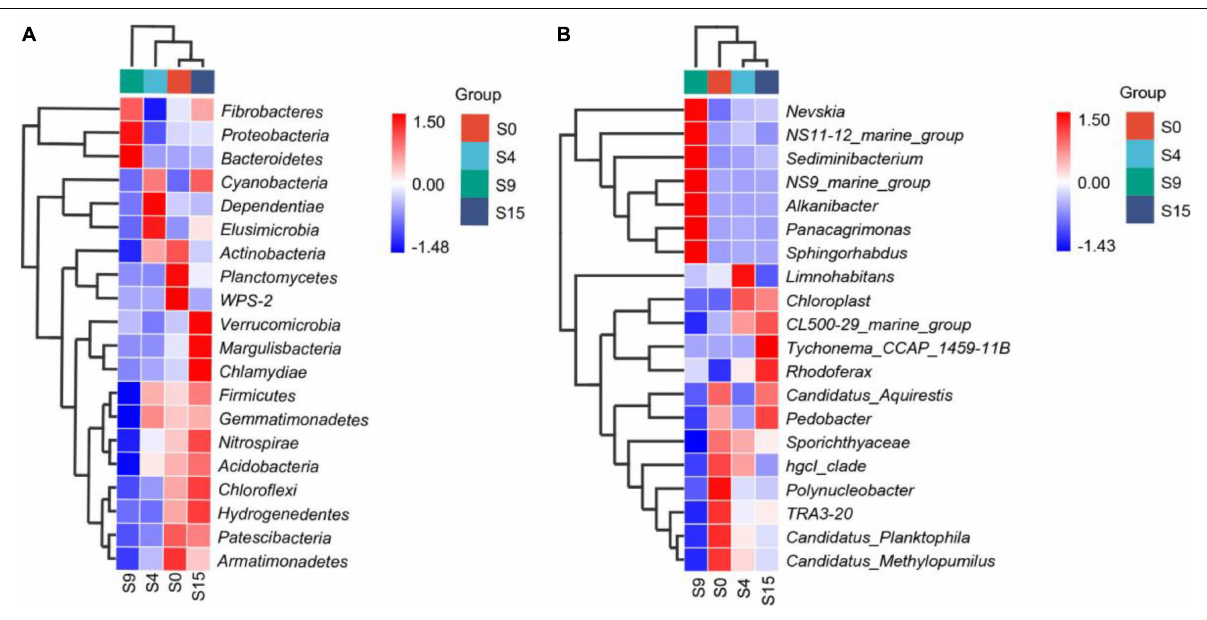
FIGURE 7 | Heat map of species composition at the phylum (A) and genus (B)